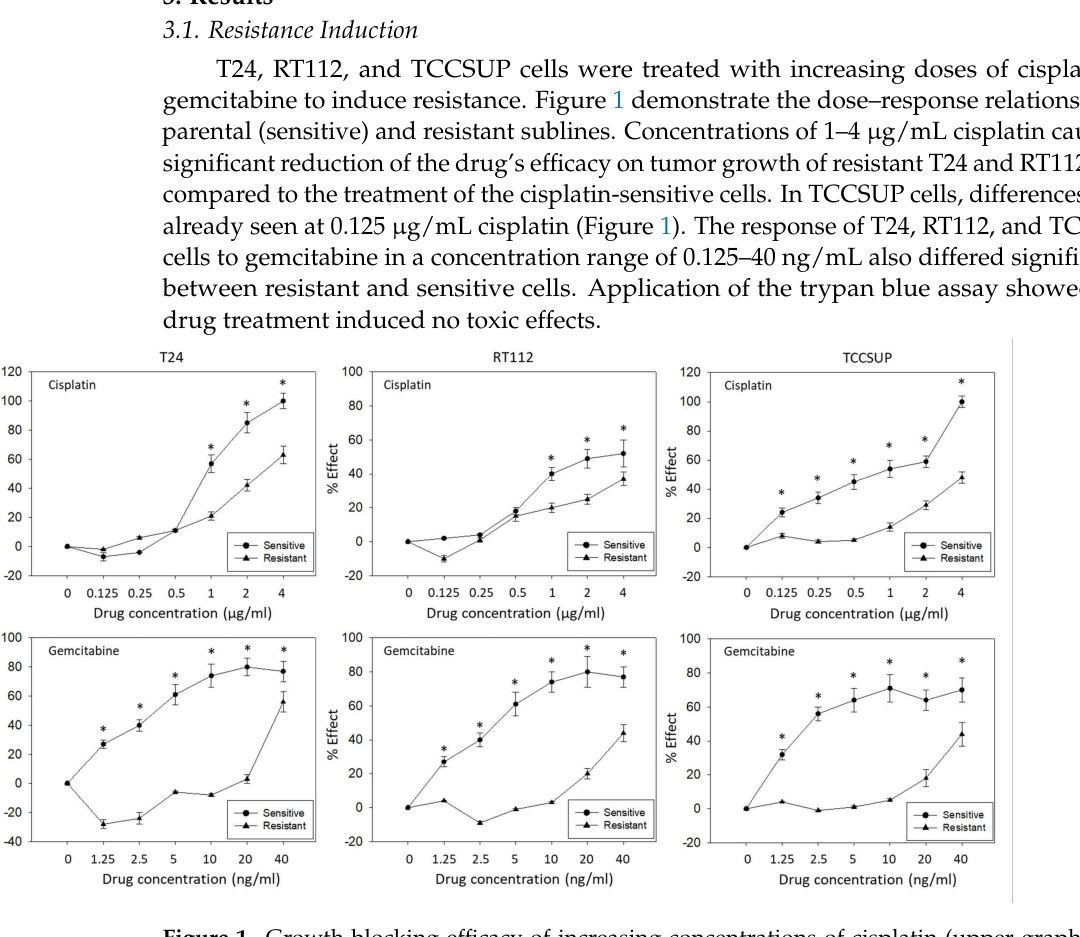
Figure 1. Growth blocking efficacy of increasing concentrations of cisplatin (upper graphs) and gemcitabine (lower graphs) on sensitive versus resistant T24, RT112, and TCCSUP bladder cancer cell lines. % Effect refers to a reduction of the 24–72 h increase in tumor cell number compared to untreated cells. (0% effect = no reduction, 100% effect = complete loss.) Error bars indicate standard deviation (SD). * indicates significant difference to the corresponding control, n =